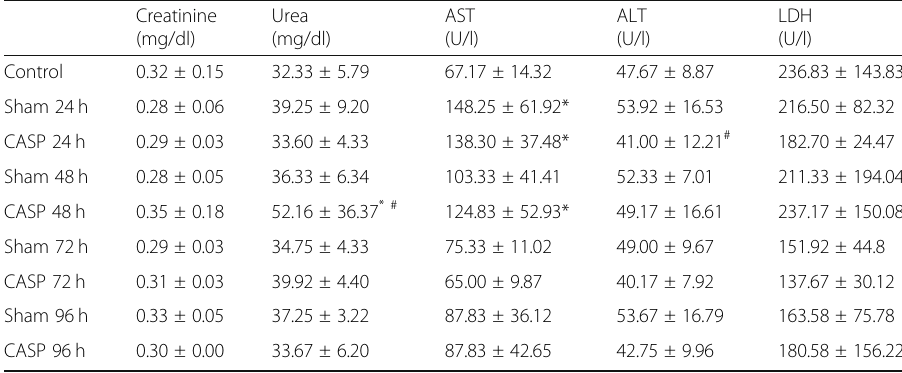
Table 2 Laboratory chemical parameters for organ damage: creatinine and urea for kidney; AST, ALT, and LDH for liver